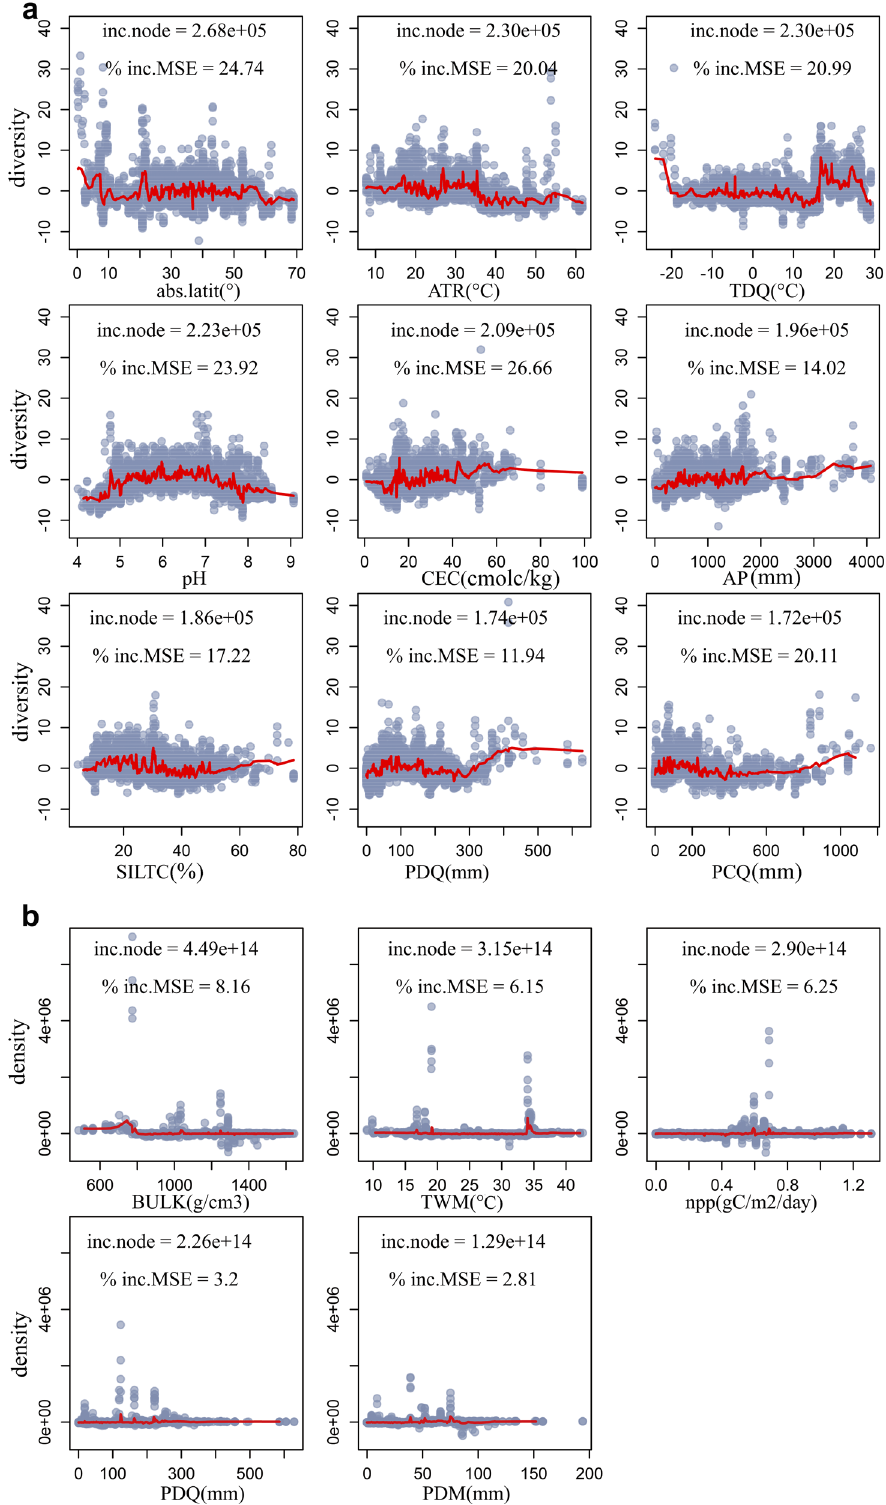
Fig. 3 Partial feature contributions (the marginal effect of a variable on response) of the most important variables for soil seed banks. a diversity; b density. Variable importance (inc. node) is the decrease in the residual sum of squares that results from splitting regression trees using the variable. The percentage increase in mean squared error (% inc. MSE) is the increase in model error as a result of randomly shuf fl ing the order of values in the vector. abs.latit, absolute latitude; AP, annual precipitation; ATR, annual temperature range; BULK, bulk density; CEC, cation exchange capacity; npp, plant productivity (net primary production); PCQ, precipitation of coldest quarter; PDM, precipitation of driest month; PDQ, precipitation of driest quarter; pH, pH measured in water; SILTC, silt (mass %); TDQ, mean temperature of driest quarter; TWM, max temperature of warmest month.